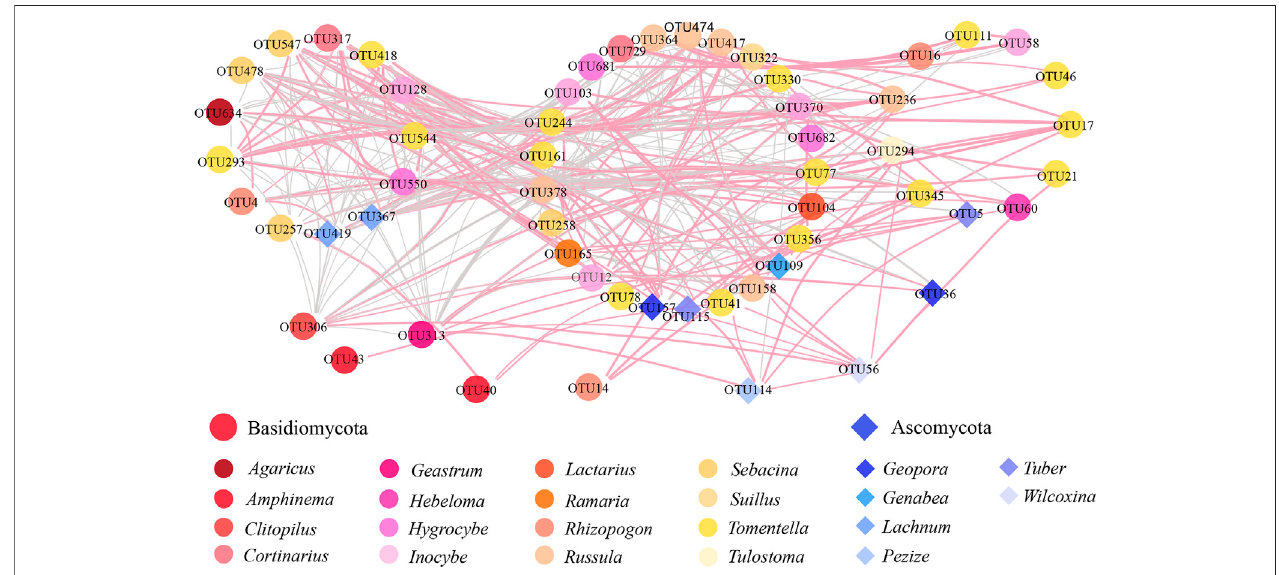
FIGURE4| EcMfungalco-occurrencenetworksof P.sylvestris plantation.Thedotsandtrianglesinthe fi gurerepresentdifferentEcMOTUs,anddifferentcolorsof shapes represent different fungal genera. The thickness of links indicates the edge weight of genera. The pink line indicates a positive correlation, and the gray line indicates a negative correlation.